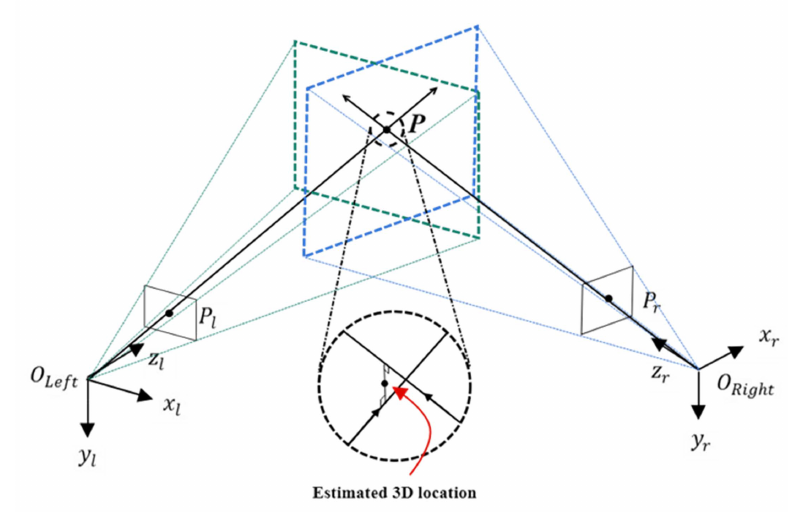
Figure 6. Calculation of 3D